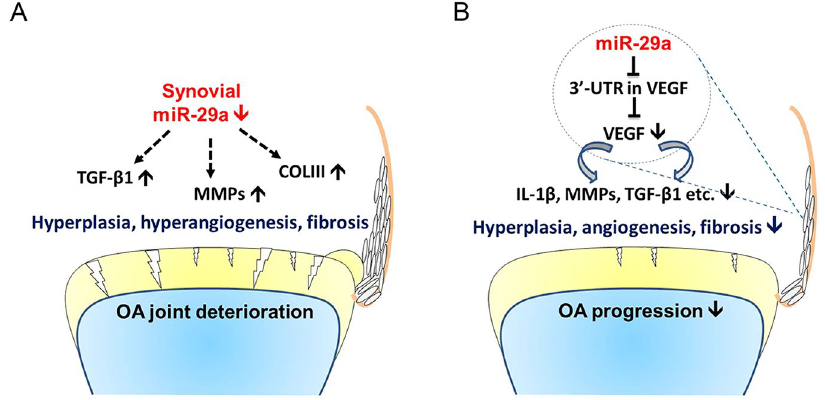
Figure 8. Scheme of miR-29a regulation of synovitis during OA knees. ( A ) miR-29a deficiency worsens synovial remodeling in terms of hyperplasia, hyperangiogenesis, and fibrosis in OA joints. ( B ) miR-29a mitigates synovitis through a direct action to the 3 ′ -UTR of VEGF that reduced VEGF secretion and thereby protects from OA